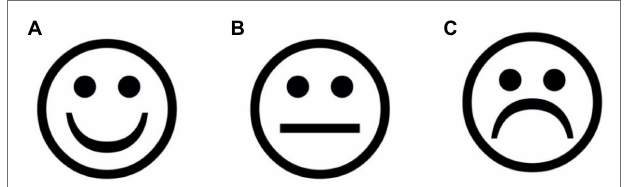
FIGURE 1 | Pictures of emotional facial expressions used in Emotion Rating: (A) Good, (B) Neither good nor bad, and (C)